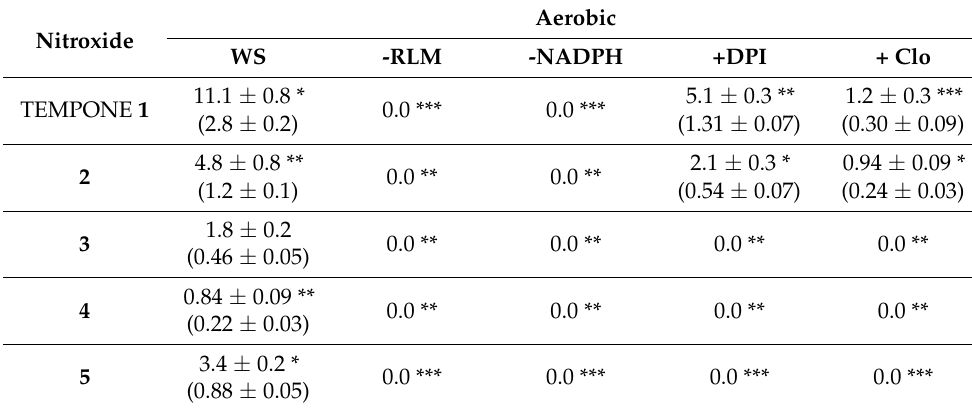
Table 3. Initial rates of decrease (nmol · min − 1 · mg − 1 prot) ((nmol · min − 1 · nmol − 1 P450)) of examined nitroxides (100 µ M) in the presence of RLM and various cofactors and inhibitors upon aerobic conditions (*** = p < 0.001, ** p < 0.01 and * = p < 0.05 for difference from aerobic WS, except for aerobic WS for which difference from anaerobic WS in Table 2 is given). The samples were prepared in potassium phosphate buffer (100 mM, pH 7.4, containing 1 mM DTPA). WS corresponds to the nitroxide incubated with RLM and NADPH added the last to initiate the reaction. The incubations were prepared at 21 ◦ C. Aerobic Nitroxide WS -RLM -NADPH +DPI + Clo 11.1 ± 0.8 * TEMPONE 1 0.0